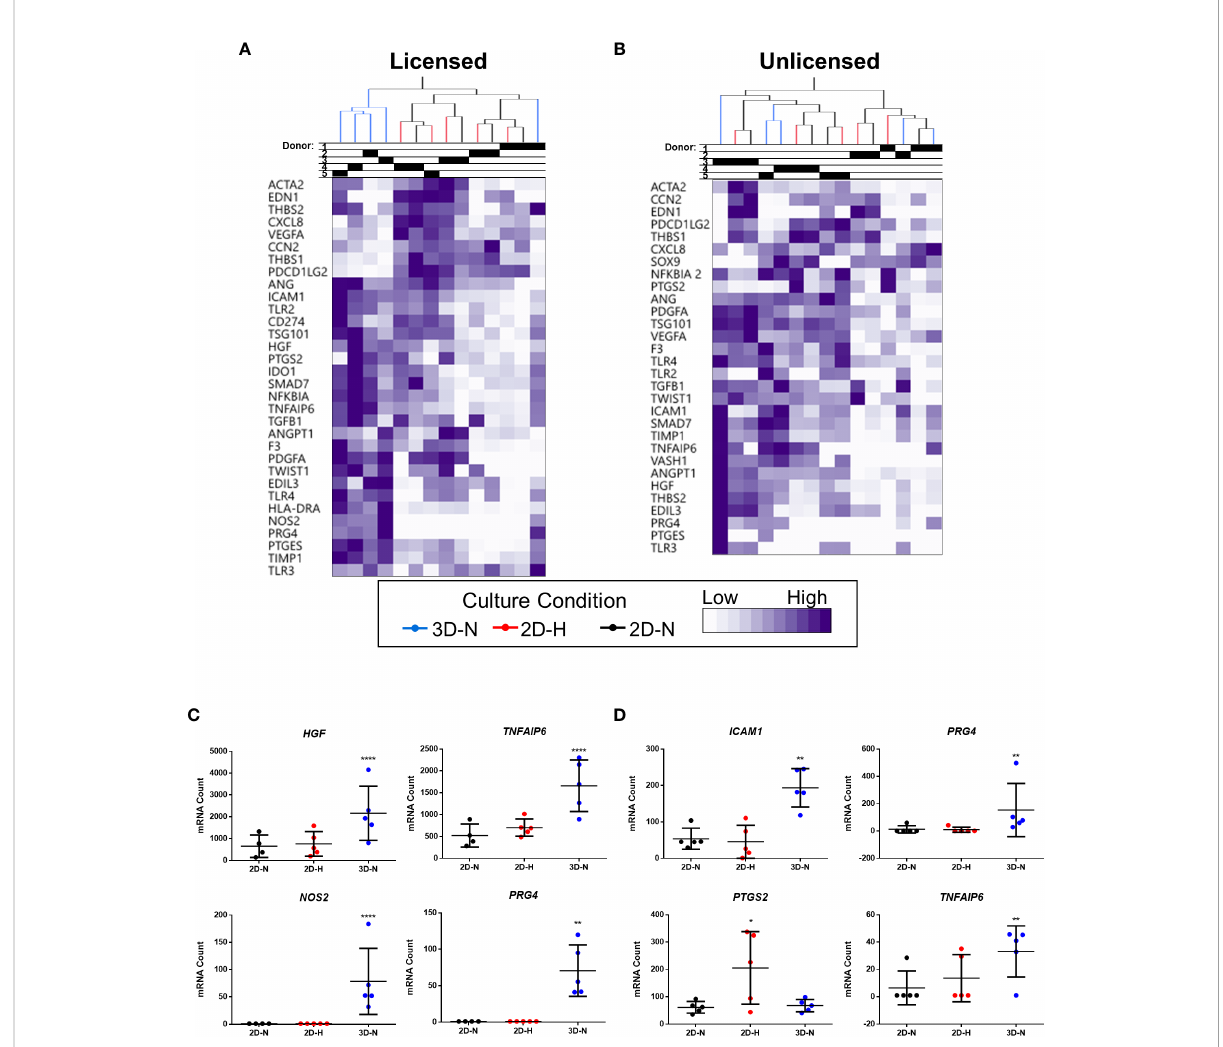
FIGURE 2 Curated gene expression panel was differentially sensitive to donor heterogeneity and select CPPs that enhance immunomodulatory and/or angiogenic potencies. A and B) Unbiased hierarchical clustering of normalized mRNA counts demonstrated clustering by CPPs (colour-coded dendrogram) and by donor (shaded regions in Donor chart indicate different donors) under both Licensed (A) and Unlicensed (B) conditions. C and D) Select genes were differentially expressed by modifying CPPs under Licensed (C) and Unlicensed (D) conditions. Multivariate linear regression, Benjamini-Yekutieli False Discovery Rate-corrected p values. *p<0.05, **p<0.01, ****p<0.0001 vs 2D-N. Horizontal bars: group mean, error bars: standard deviation. 3D-N, 3D Normoxic culture; 2D-N, 2D Normoxic culture; 2D-H, 2D Hypoxic culture. N=5 MSC(AT) donors, n=1 technical replicate due to high sensitivity of Nanostring